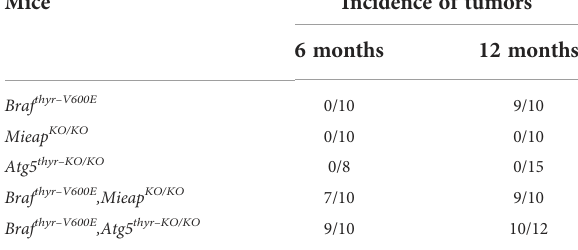
TABLE 1 Summary of incidences of thyroid tumors in Braf thyr – V600E , Mieap KO/KO , Atg5 thyr – KO/KO , Braf thyr – V600E ,Mieap KO/KO , and Braf thyr – V600E ,Atg5 thyr – KO/KO